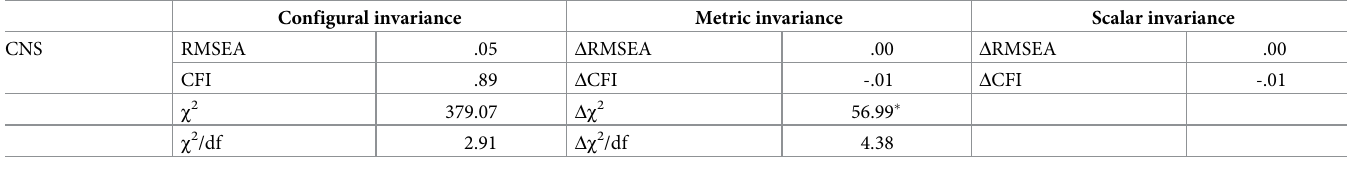
Table 3. RMSEA, CFI, χ 2 and χ 2 /df in the different invariance